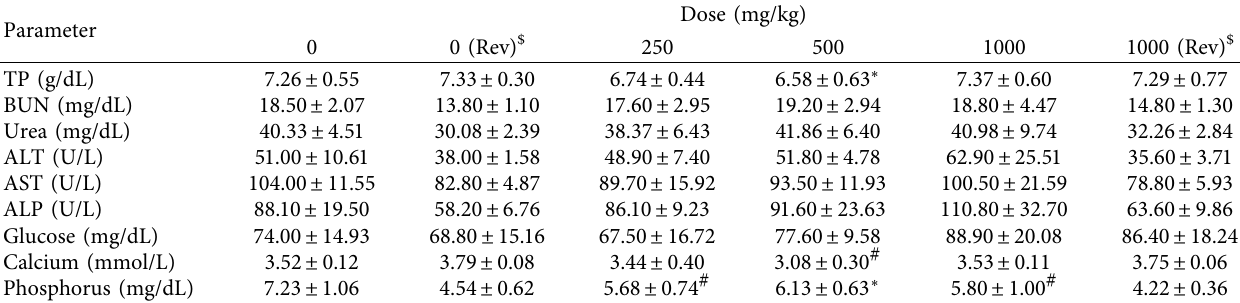
Table 6: Effect of GutGard on biochemistry parameters of female rats during 90D oral toxicity study.